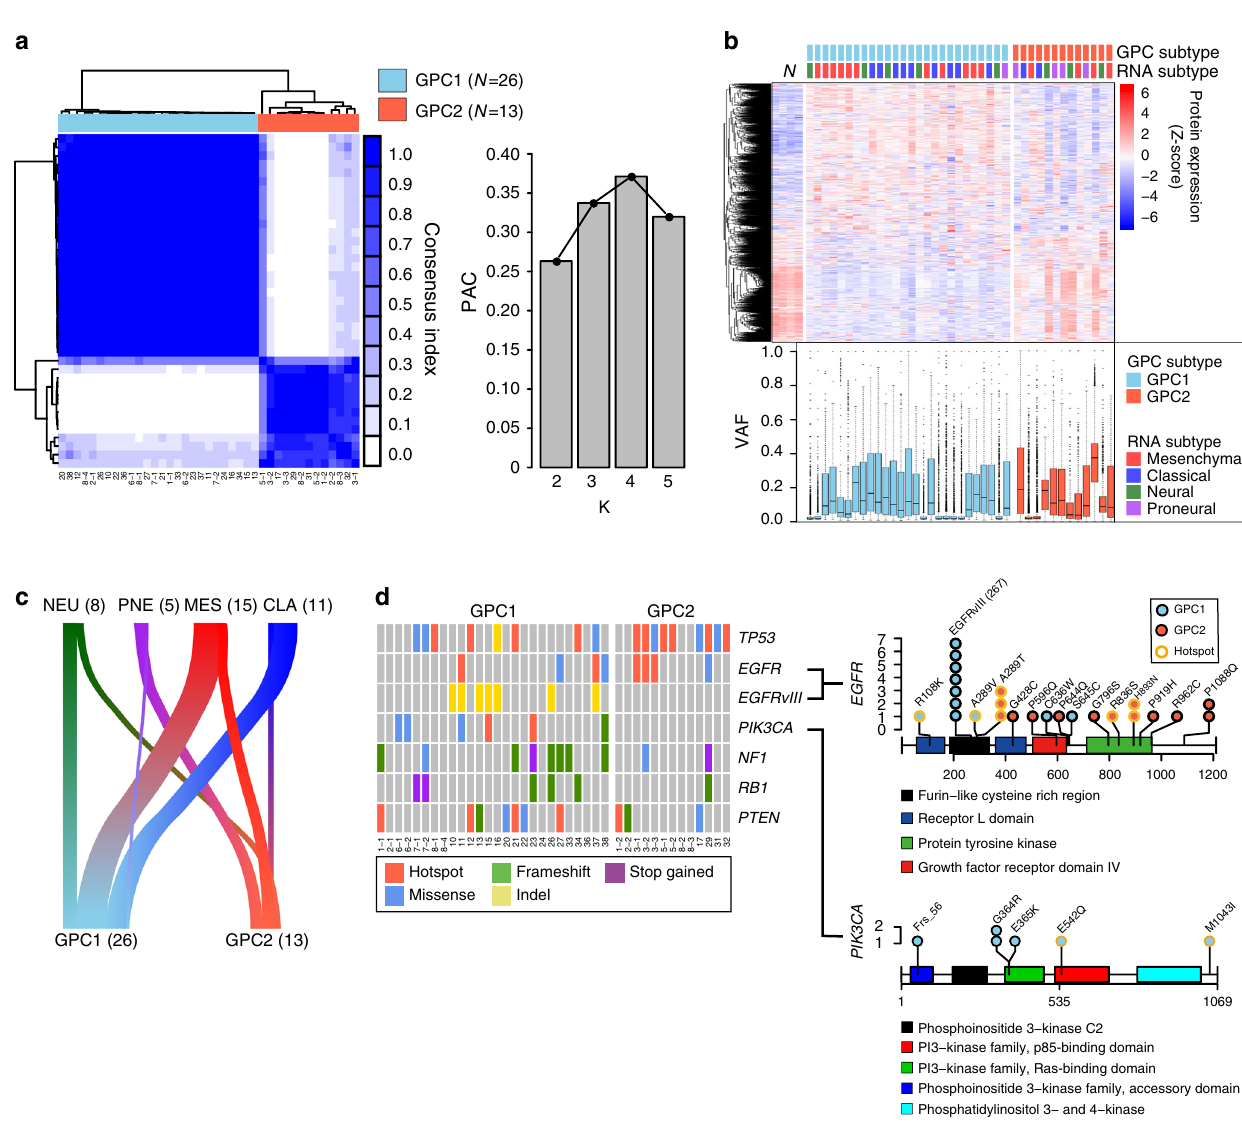
Fig. 2 Proteomic subtypes of IDH wild-type GBM associate with clinical and genomic features. a Consensus clustering of IDH wild-type GBM samples ( N = 39) based on global proteome data using 1 – Pearson ’ s correlation coef fi cient as the distance metric. (Left) Heatmap of the consensus score. (Right) The bar chart indicates the proportion of ambiguous clustering (PAC) for the indicated K values. The number of clusters (K) with the lowest PAC score is considered the optimal cluster number. b Characteristics of proteomic subtypes. The columns represent the samples grouped by proteomic subtype. The clustering heatmap represents the Z -score-normalized protein expression levels. The box-and-whisker plot represents the medians (middle line), fi rst quartiles (lower bound line), third quartiles (upper bound line), and the ±1.5× interquartile ranges (whisker lines) of the variant allele frequency (VAF) of single nucleotide variants (SNVs) 19 per sample. N: normal control samples. c The river plot illustrates the association between proteomic and RNA subtypes. The width of the edge between two subtypes is shown in proportion to the number of corresponding samples. CLA classical, PNE proneural, NEU neural, MES mesenchymal. Correlation between the two subtyping methods was insigni fi cant by the chi-square test ( P = 0.122). d GBM driver mutations associated with proteome subtypes. (Left) The color-coded matrices indicate the cBioPortal-annotated mutation types in the samples grouped by proteomic subtype for the six frequently mutated genes in GBM. (Right) Somatic mutations in EGFRvIII and PIK3CA that were exclusively found in GPC1 and GPC2 tissues. The x axis indicates the position in the gene, and the y axis indicates the frequencies of the mutations. The color in the circle indicates a mutation found either in a GPC1 (blue) or in a GPC2 (red) sample. The outline color of the circle indicates the hotspot mutations. Rectangles with different colors represents protein domains. Source data are provided as a Source Data fi